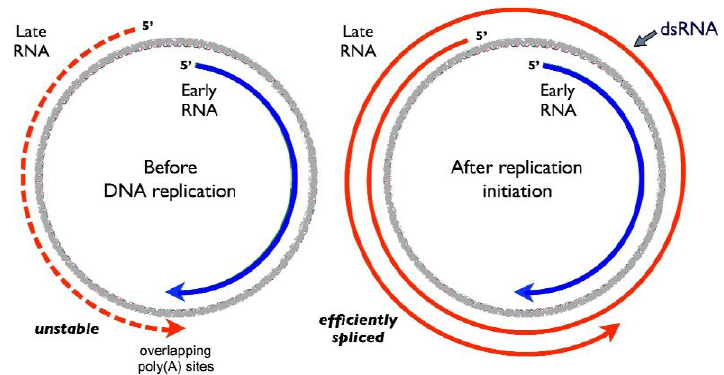
Figure 3. The early–late switch is associated with poly(A) signal readthrough and double-stranded RNA (dsRNA) formation. See text for details of the regulation. At early times and before viral DNA replication ( left ), transcription occurs from both the early and late promoters. Early-strand RNAs are spliced to produce mRNAs for the early proteins. Late-strand transcripts are efficiently terminated and polyadenylated, but are unstable and produce only small amounts of late mRNAs and proteins. After the onset of DNA replication ( right ), transcription termination and polyadenylation become less efficient, allowing multigenomic transcripts to be produced. Giant transcripts are efficiently spliced to generate stable late mRNAs, but sequences antisense to early-strand transcripts can downregulate early genes.